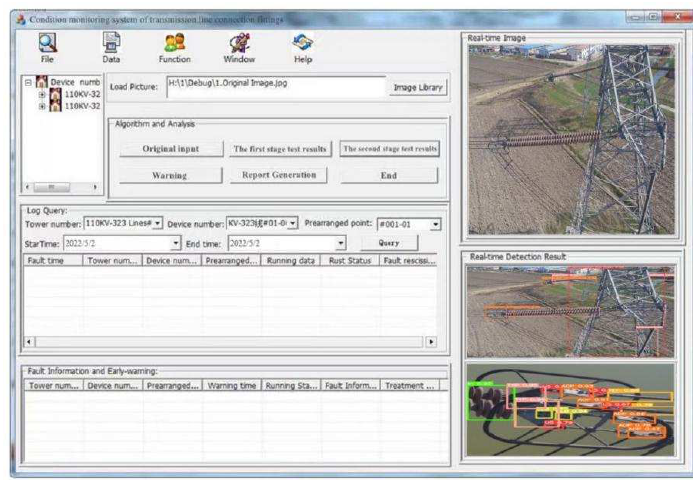
Figure 21. Condition monitoring system of transmission line connection fittings.